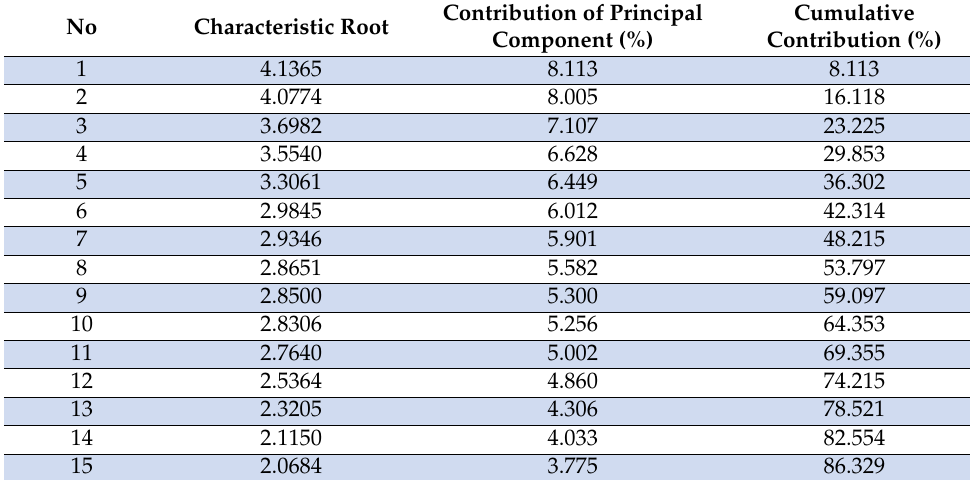
Table 4. Principal component